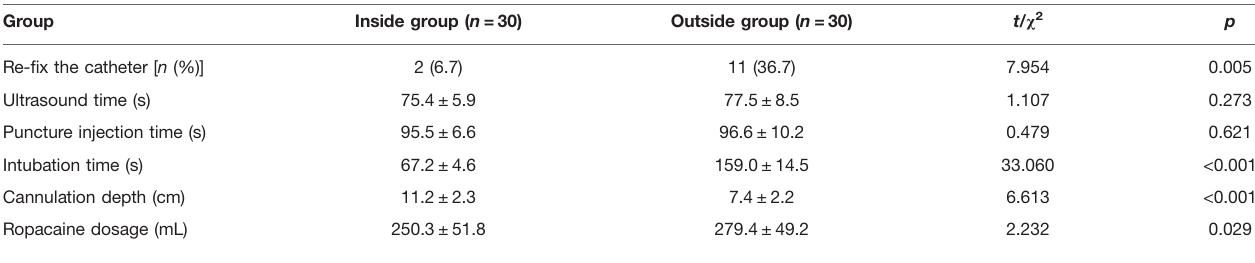
TABLE 2 | Comparison of nerve block – related indicators between two groups. Group Inside group ( n